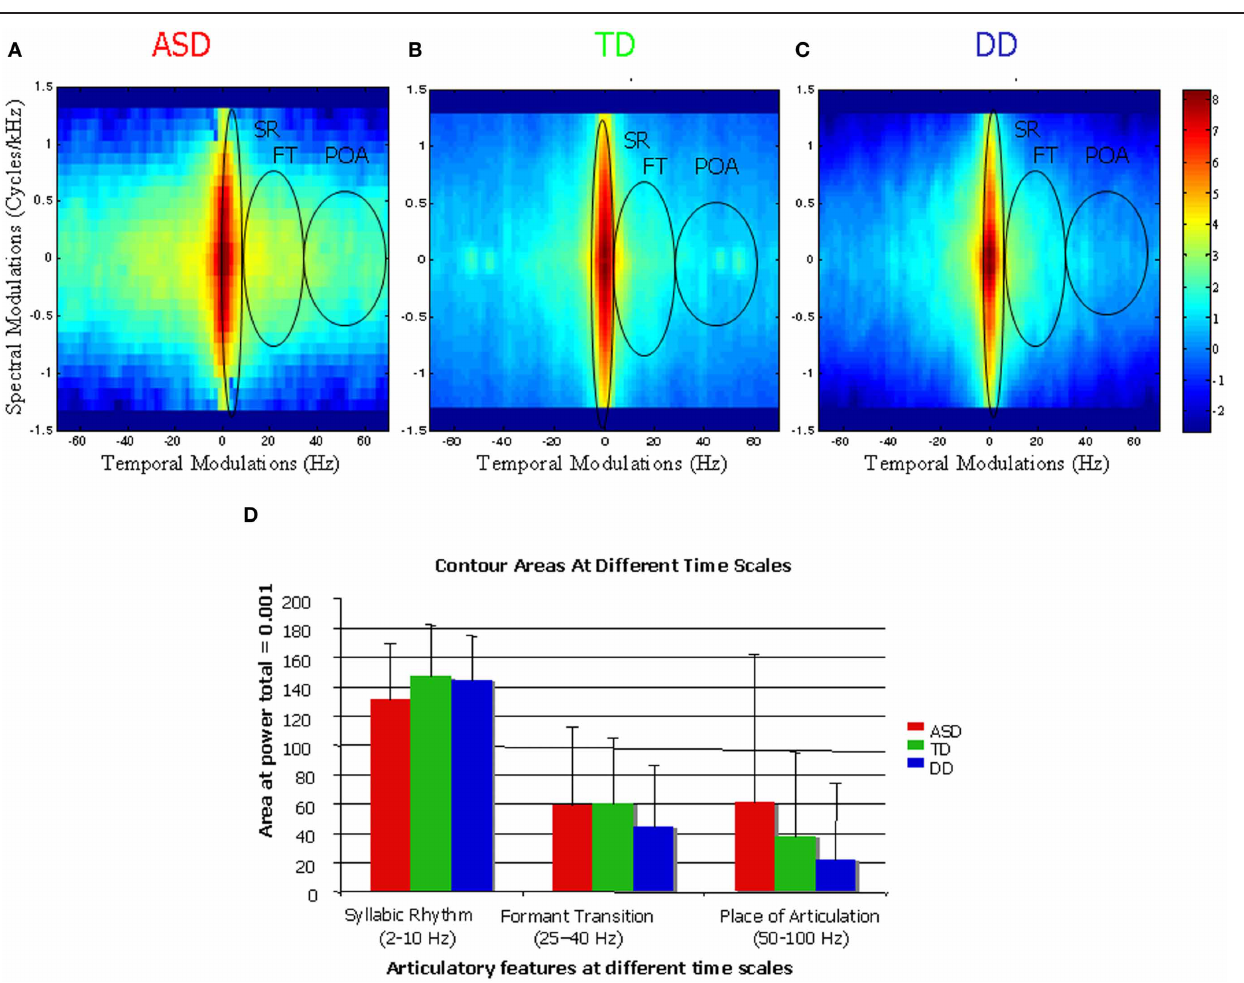
FIGURE 3 | Contourareas encompassing 99.9% energy in the distribution of spectro-temporalmodulationsin representative speech samples of the three groups—ASD(A), TD (B), and DD (C). Panel (D) shows a quantification